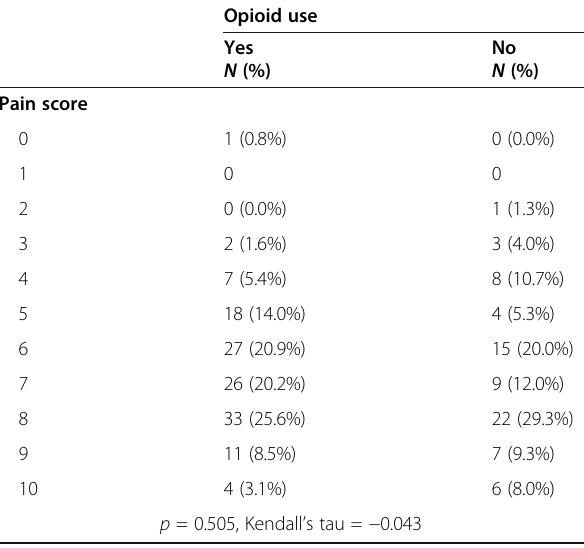
Table 6 Association between opioid use and Numeric Pain Rating Scale score ( n =